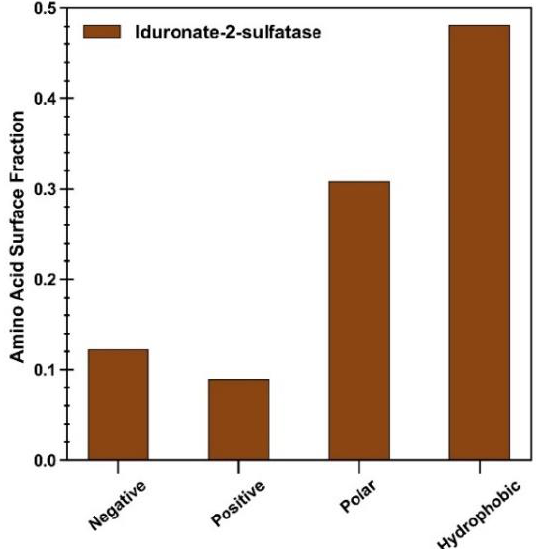
Figure A12. Surface amino acid composition of iduronate-2-sulfatase at pH 7 in its native state. Sur- face residues consisted of 393 out of the 516 total residues.